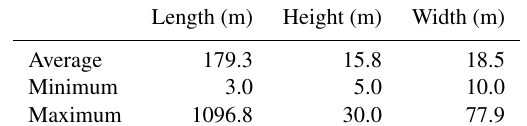
Table 3. List of the sensitivity simulations performed using both MUNICH and SinG with different time steps (100 and 600s) and adopting (or not) the stationary